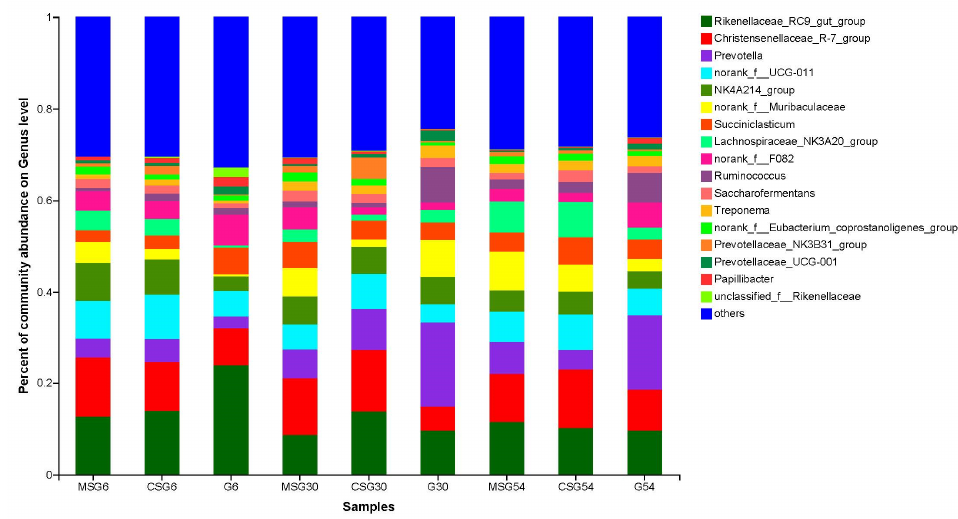
Figure 4. Microbial composition in the rumen of yaks at the genera level.